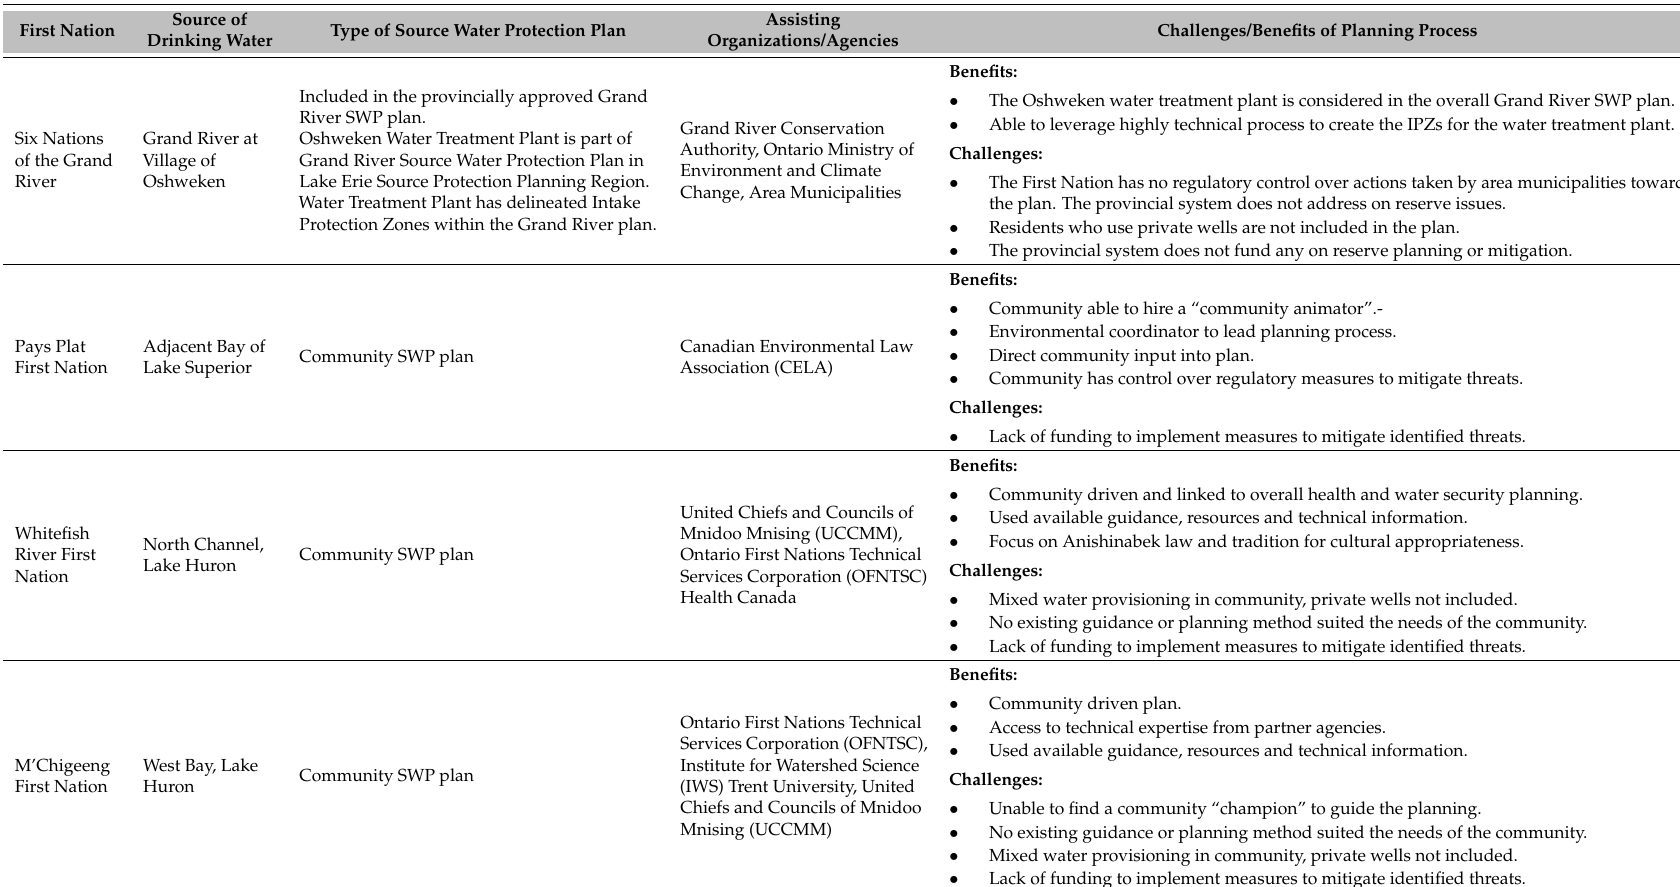
Table 1. Summary of Examples of First Nations Source Water Protection